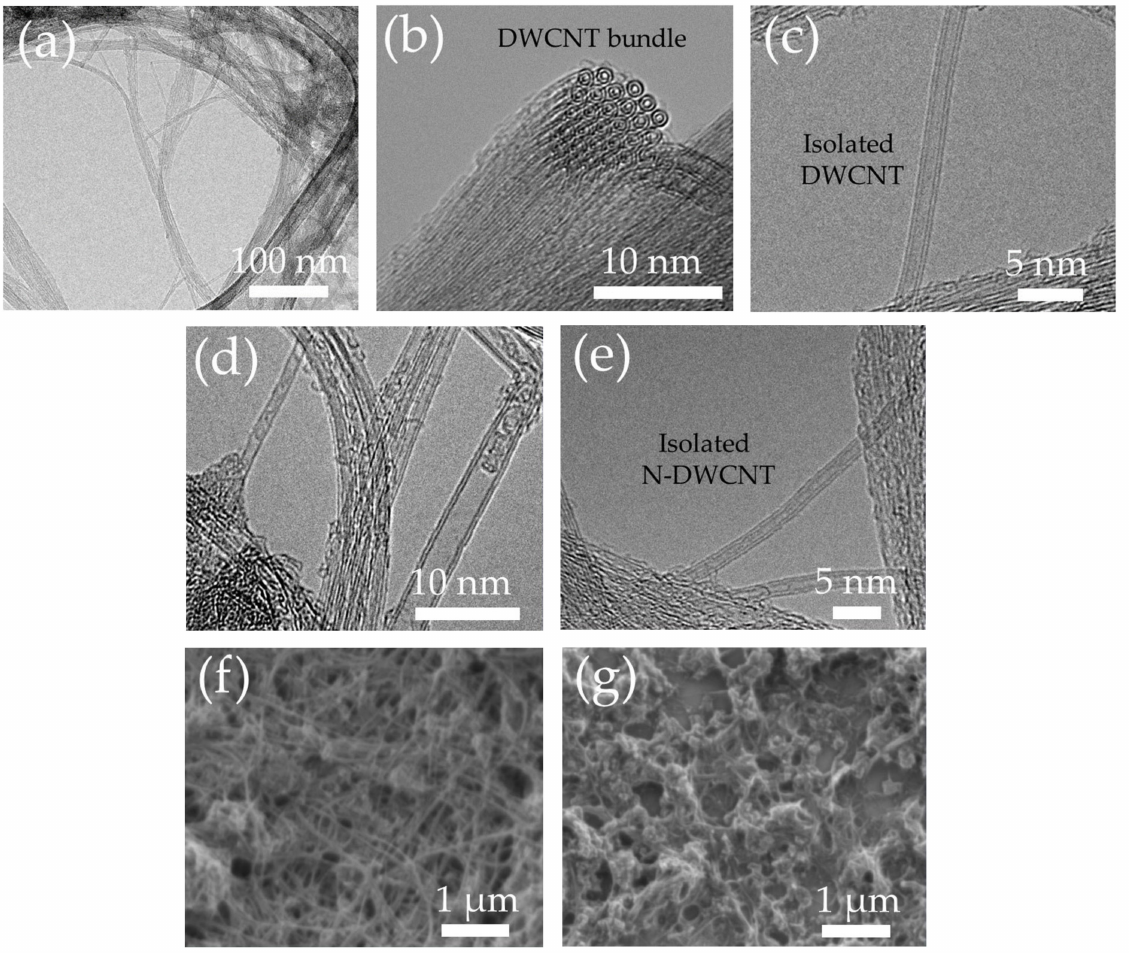
Figure 1. TEM images of ( a – c ) DWCNTs and ( d , e ) N-DWCNTs. FESEM images of ( f ) N-DWCNTs and ( g ) PVP/N-DWCNTs on